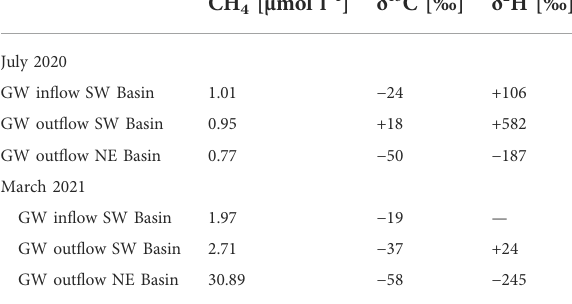
TABLE 3 Methane concentration and its stable isotopic composition of the three different groundwater wells during the strati fi cation period (July 2020) and the mixing period (March